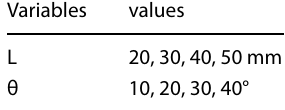
Table 3 Values of L and